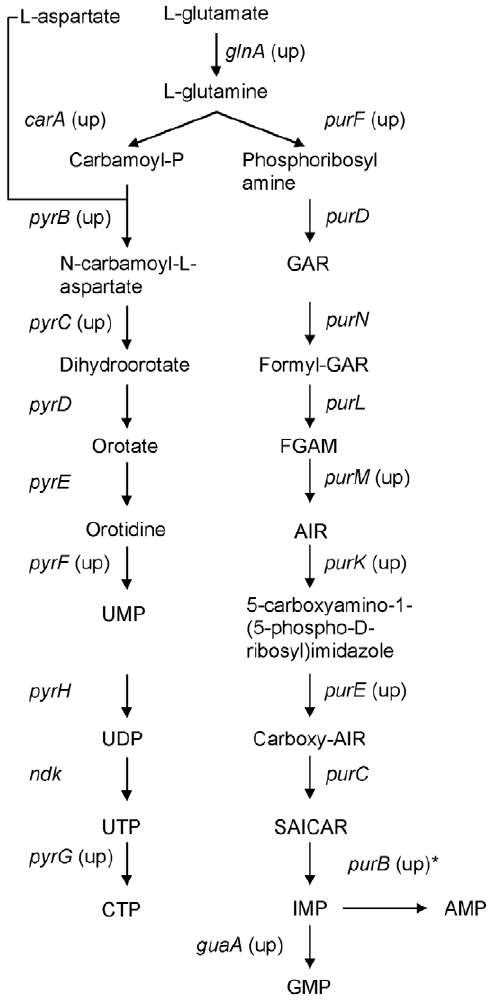
Figure 4. Expression levels of ribosomal protein genes at different co-cultivation time points (relative to T=0min). Each differently coloured line represents one gene (identified in Table S3).